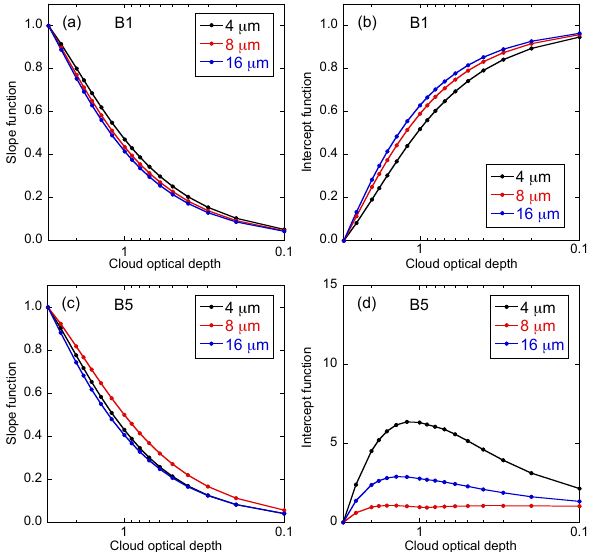
Figure 5. (a) Slope and (b) intercept functions derived from band B1 (400–870 nm wavelengths). (c) and (d) are the same as (a) and (b), but derived from band B5 (2110–2220 nm wavelengths). Each plot shows results for three cloud drop effective radius values: 4, 8, and 16 µm.